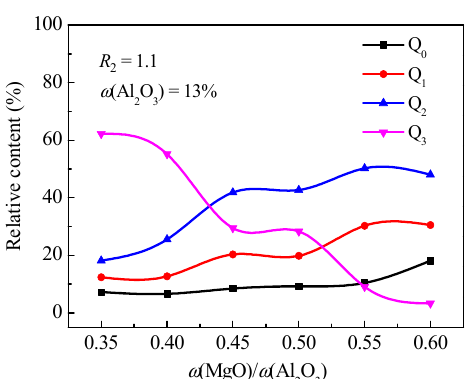
Figure 7. Deconvolution results of the FTIR curves with various ω (MgO)/ ω (Al 2 O 3 ) ratios, and ( a ) the ω (MgO)/ ω (Al 2 O 3 ) is 0.35, ( b ) the ω (MgO)/ ω (Al 2 O 3 ) is 0.40, ( c ) the ω (MgO)/ ω (Al 2 O 3 ) is 0.45, ( d ) the ω (MgO)/ ω (Al 2 O 3 ) is 0.50, ( e ) the ω (MgO)/ ω (Al 2 O 3 ) is 0.55, ( f ) the ω (MgO)/ ω (Al 2 O 3 ) is 0.60.